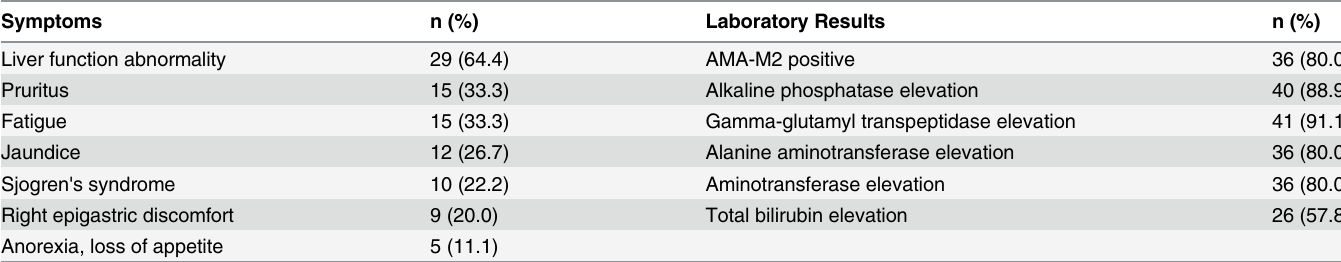
Table 2. Clinical characteristics of the 45 PBC